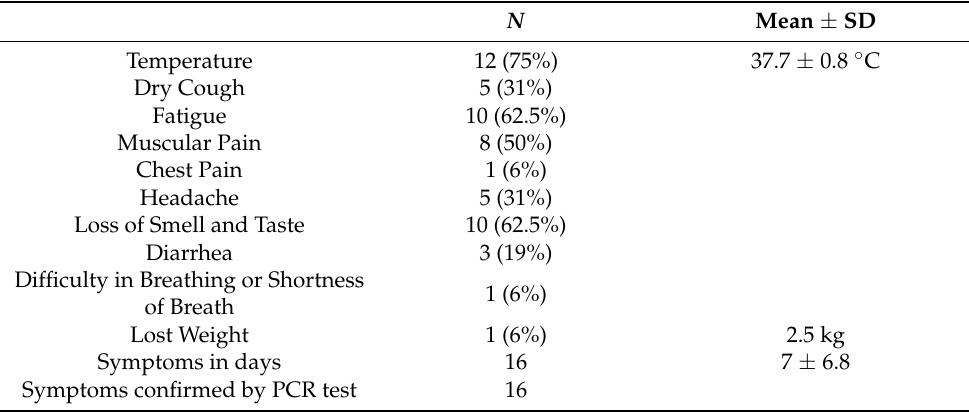
Table 2. COVID-19